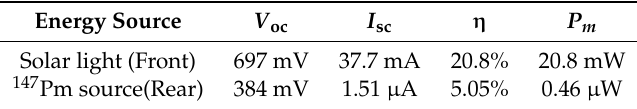
Table 1. Simulated results with optimized